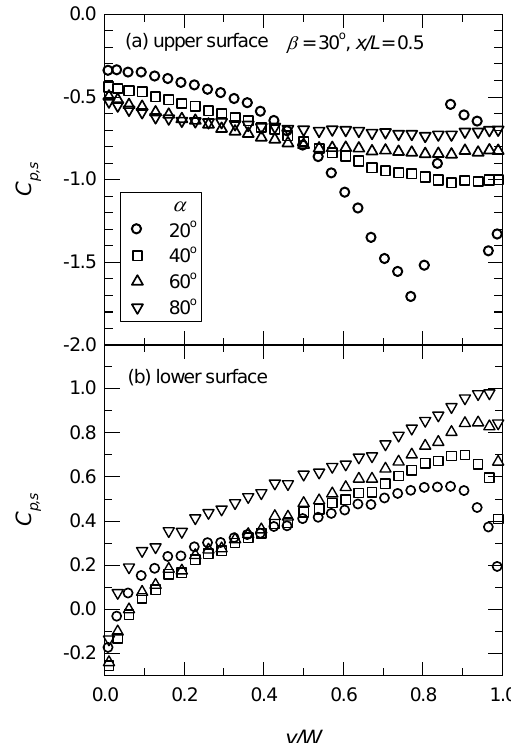
Figure 6. Mean spanwise pressure distributions for x/L = 0.5 and β = 0° .